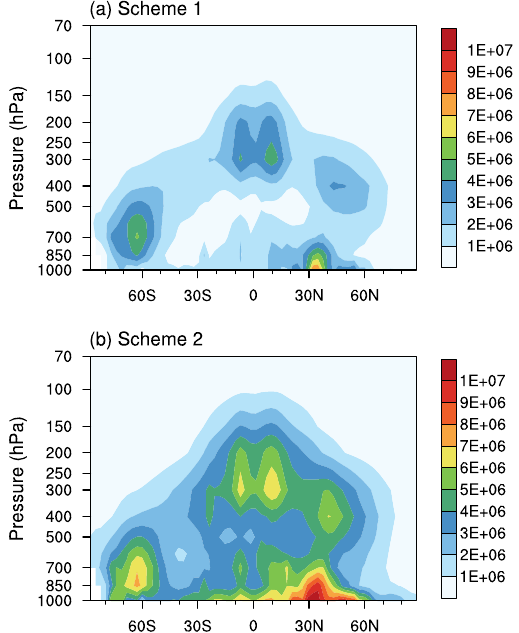
Fig. 1. Annually and zonally averaged sulfuric acid gas concentra- tions (unit: number of molecules per cm 3 ) simulated by two con- figurations of the aerosol-climate model ECHAM-HAM, version 2. Panel (a) corresponds to time stepping scheme 1 in Table 1 which solves the sulfuric acid equation (Eq. 1) using the Euler forward scheme with sequential splitting; Panel (b) uses scheme 2 in Ta- ble 1, originally introduced by Kokkola et al. (2009). The simulation setups are described in Sect.